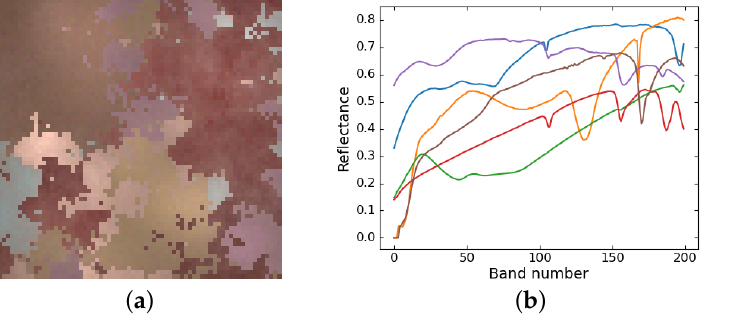
Figure 3. A pseudo color image of synthetic data and endmembers. ( a ) Pseudo color image. ( b ) End- member